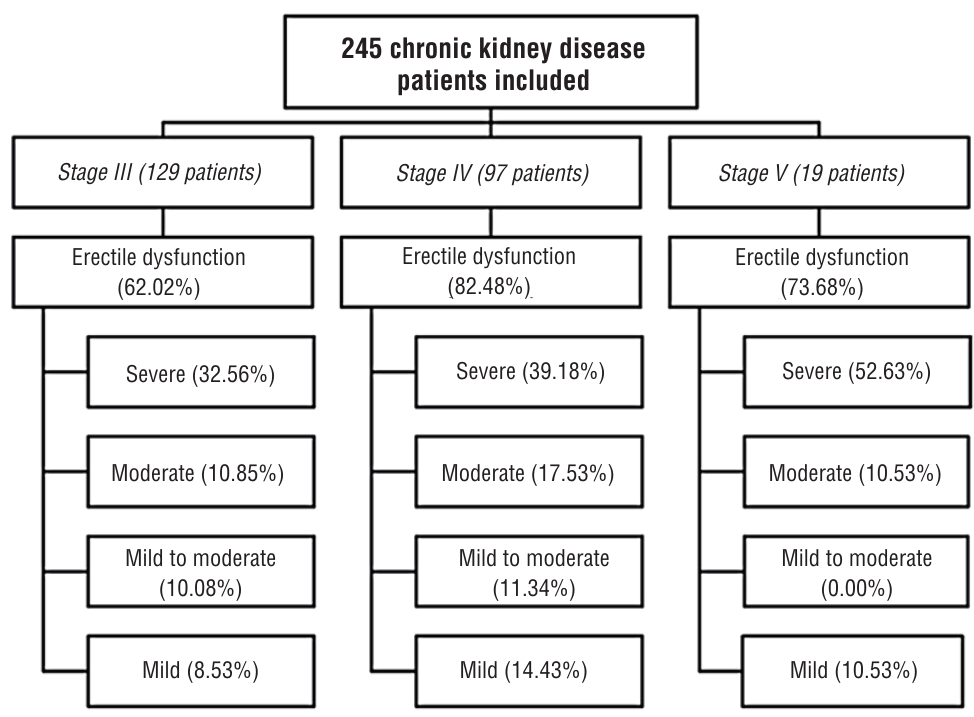
Figure 1 - Erectile dysfunction and the proportion of severe degree in each stage.